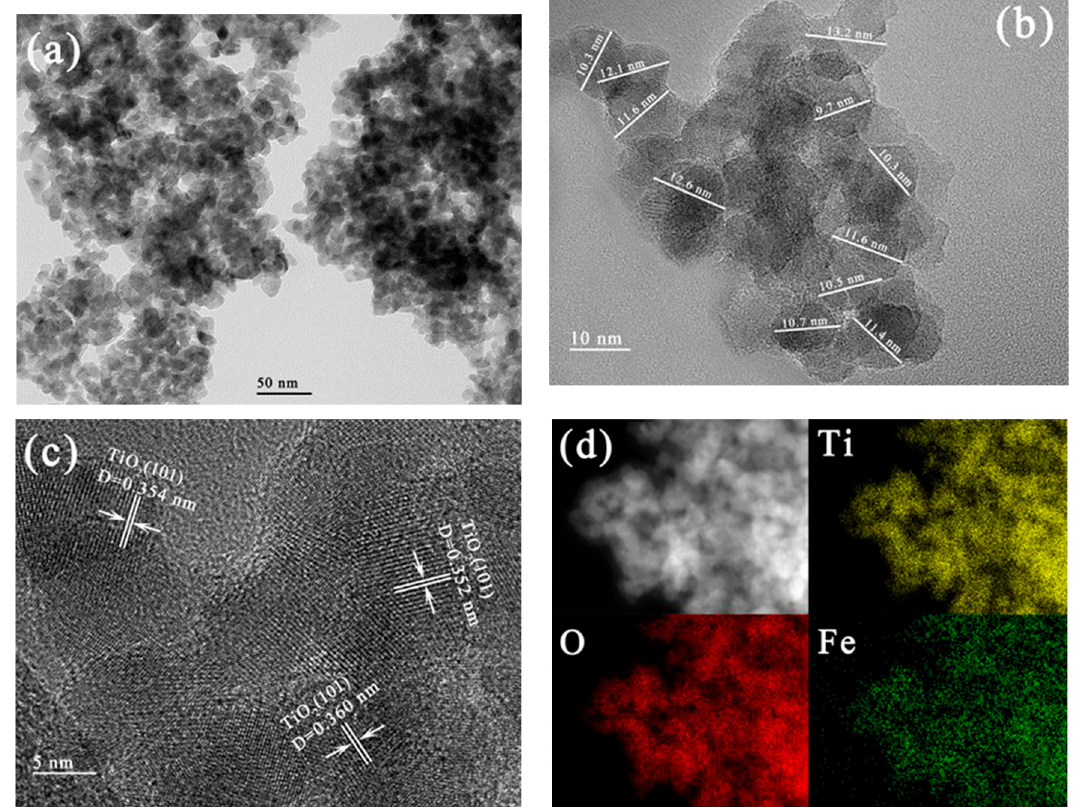
Figure 7. TEM ( a ) and HRTEM ( b,c ) images, energy dispersive X-ray (EDX) mapping ( d ) of 5%Fe-TiO 2 .